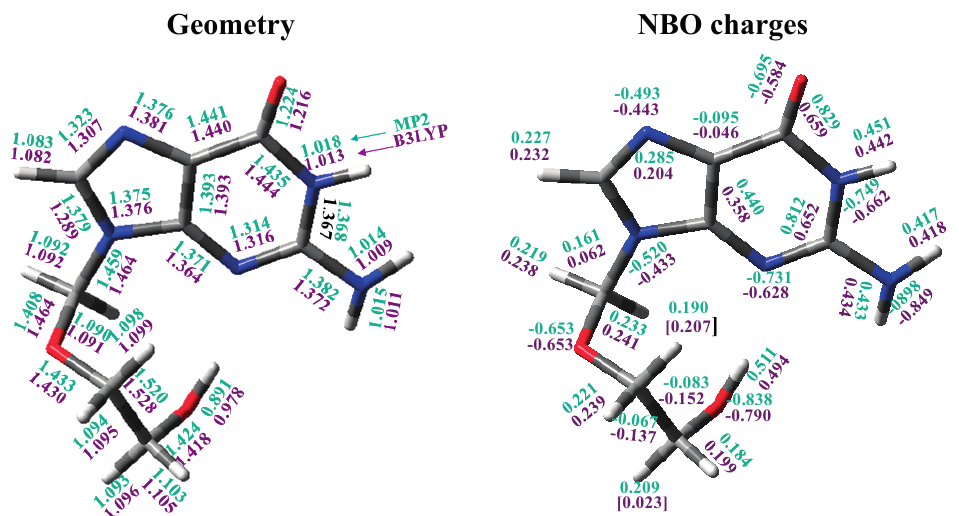
Figure 5. Natural atomic charges and optimum bond lengths in conformer B2 of tautomer N1 of acyclovir at B3LYP/6-31G(d,p) and MP2/6-31G(d,p) levels, in fuchsia and green colours,